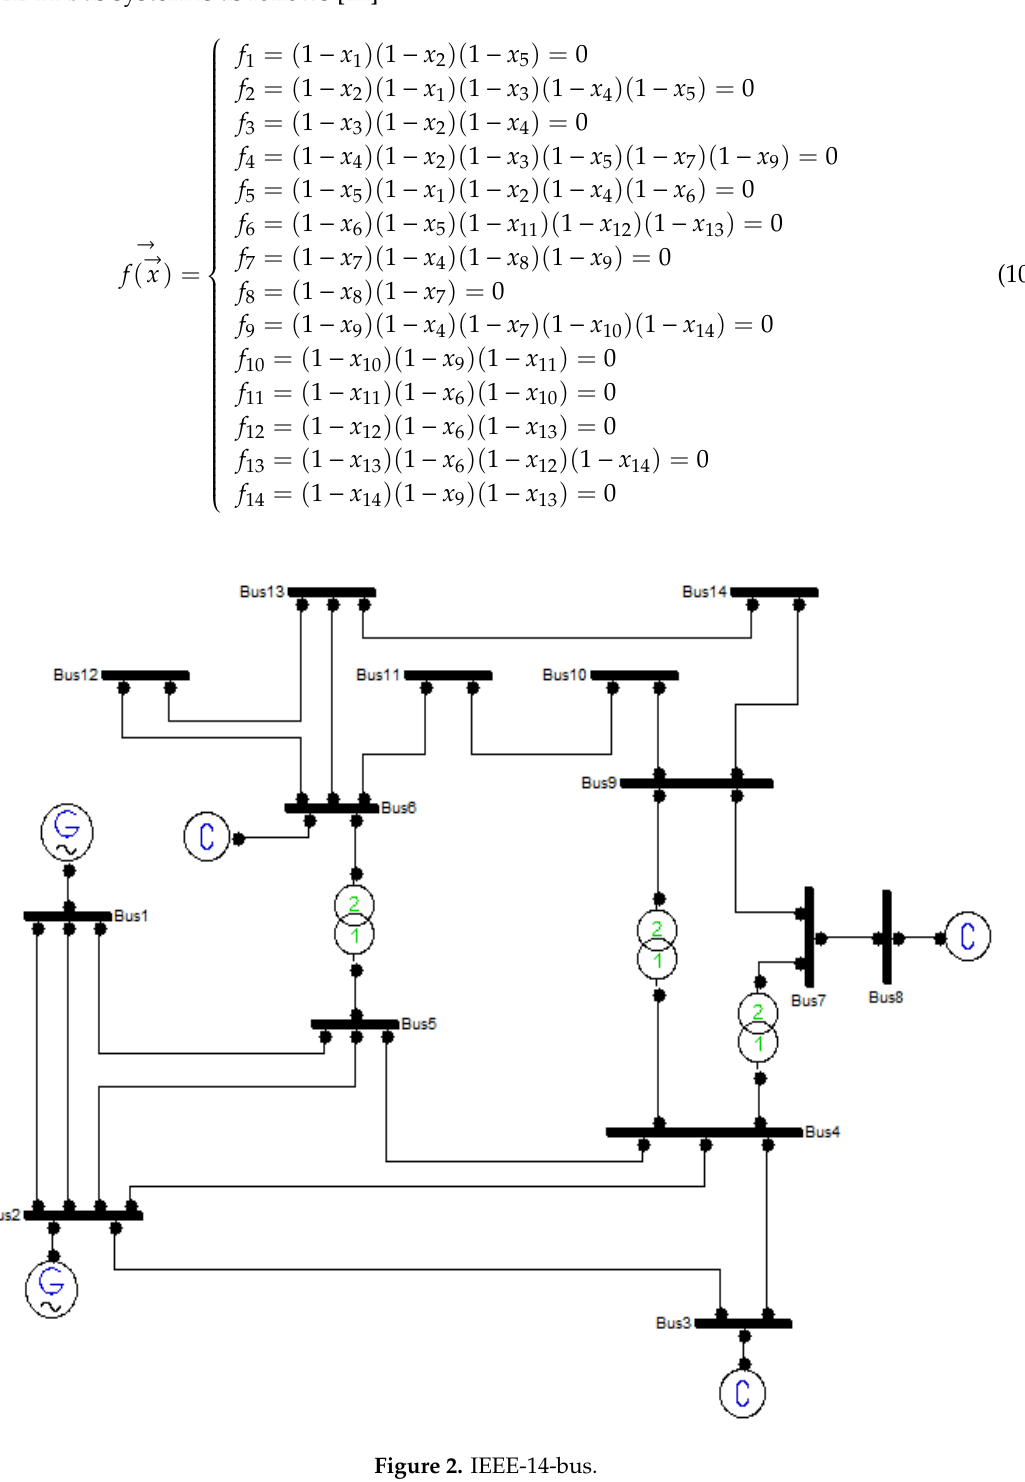
Figure 2. IEEE-14-bus. Figure 2.